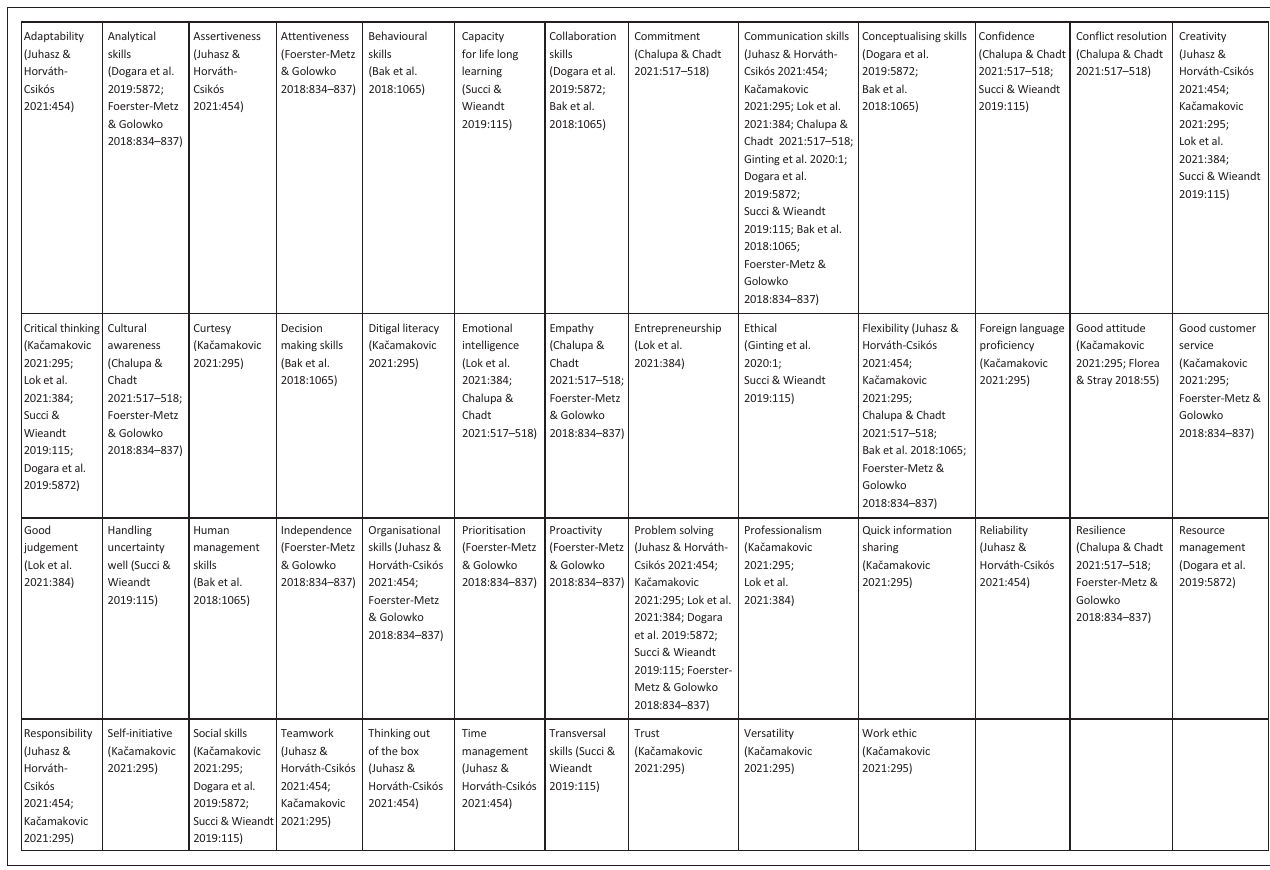
FIGURE 1: A summary of the soft skills identified through reviewing the